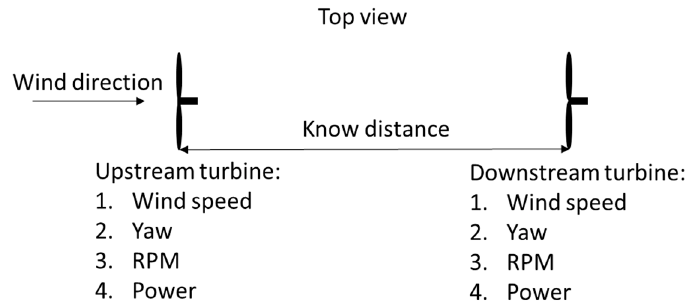
Figure 1. Annotated schematic of a pair of turbines.